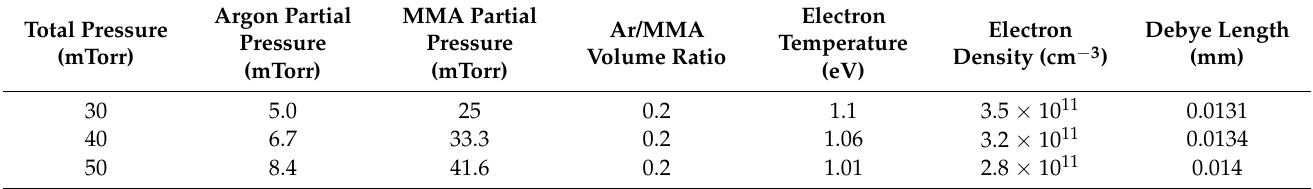
Table 3. Results of calculations for Te and ne, as well as Debye length, as a function of working pressure. (1 mTorr = 0.133